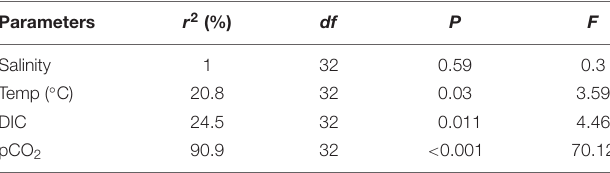
TABLE 4 | Multiple regression analysis with a stepwise variable